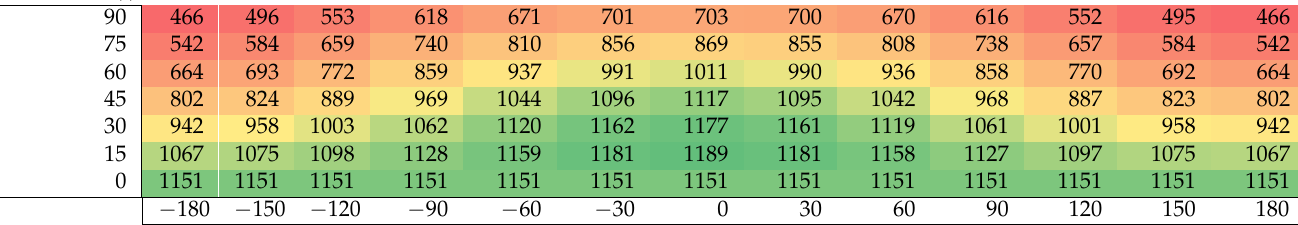
Table 4. Annual production (in kWh/year) of a 1000 Wp PV installation and an obstruction angle of 30 ◦ as a function of the azimuth and inclination of collectors.